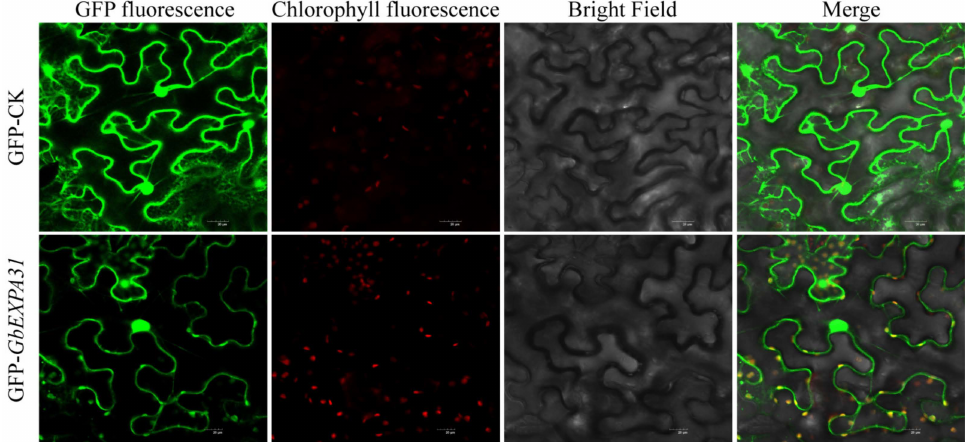
Figure 2. GbEXPA31 subcellular localization. GFP-CK: GFP blank vector, transient expression of GbEXPA31 fusing GFP in tobacco (Nicotiana benthamiana) epidermal cells by confocal laser microscopy. Scale bars = 20 µ